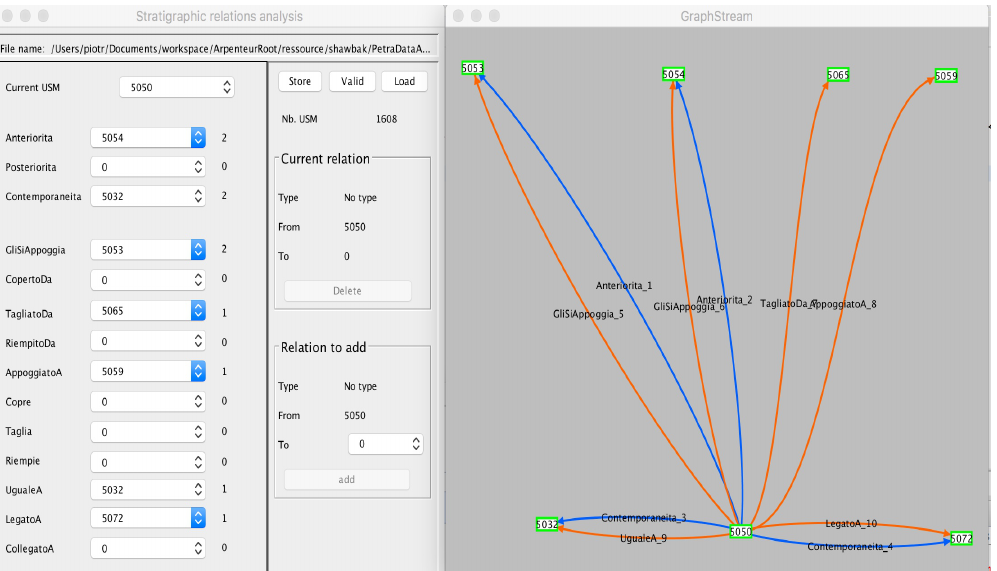
Figure 12. Physical and stratigraphic relations editor with graph visualization of all the relations in which the current USM is involved. A color code is used to separate physical relations from stratigraphic relations.